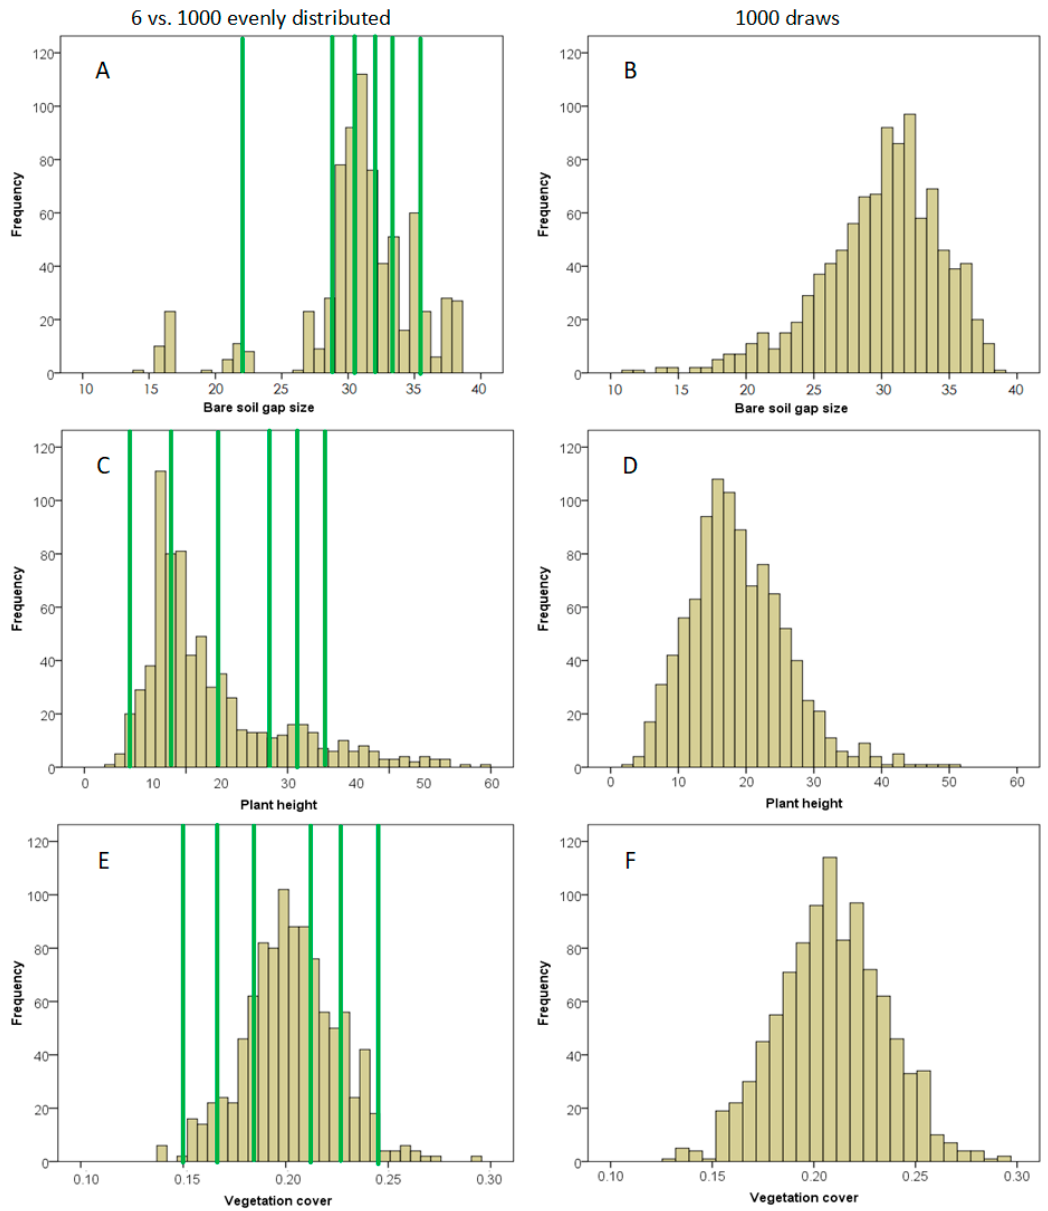
Figure 5. Histograms exhibit the mean of bare soil gap size, plant height, and vegetation cover for six and 1000 evenly distributed transect lines ( A , C , E : green lines represent six evenly distributed transect lines and yellow lines represent 1000 evenly distributed transect lines) and 1000 draws ( B , D , F ) of Treatment 3 (75% grass removal).